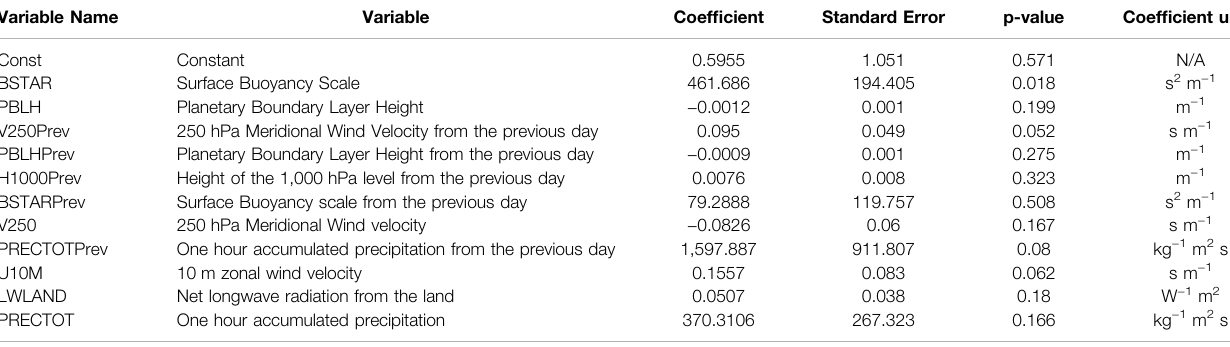
TABLE 1 | Description of the machine-learning model and the constituent coef fi cients.